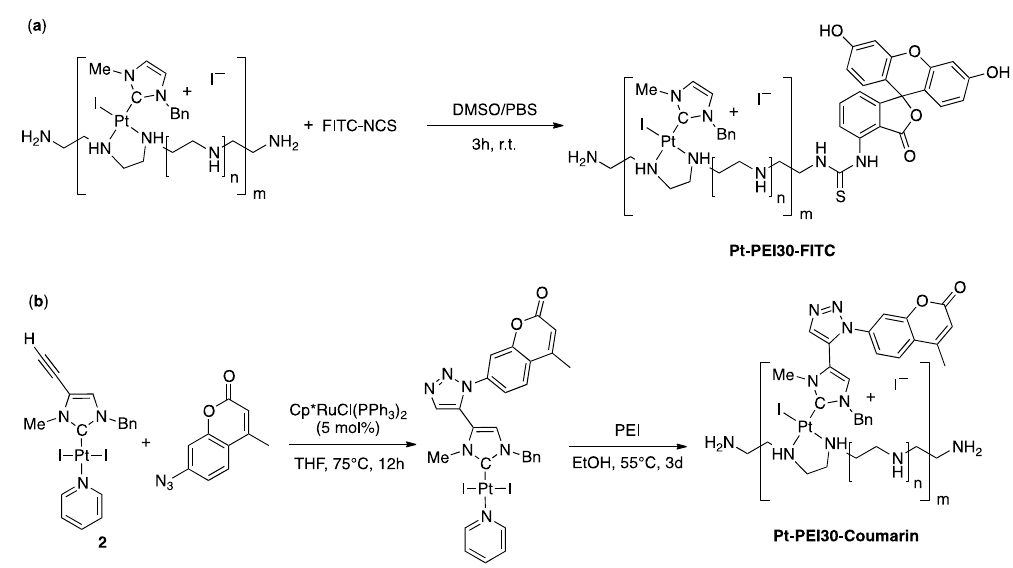
Figure 3. Synthesis of FITC-labelled Pt-PEI30 Pt-PEI30-FITC ( a ) and direct functionalization of the NHC platinum complex 2 prior to synthesis of the NHC-Pt-PEI conjugate Pt-PEI30-Coumarin ( b ).